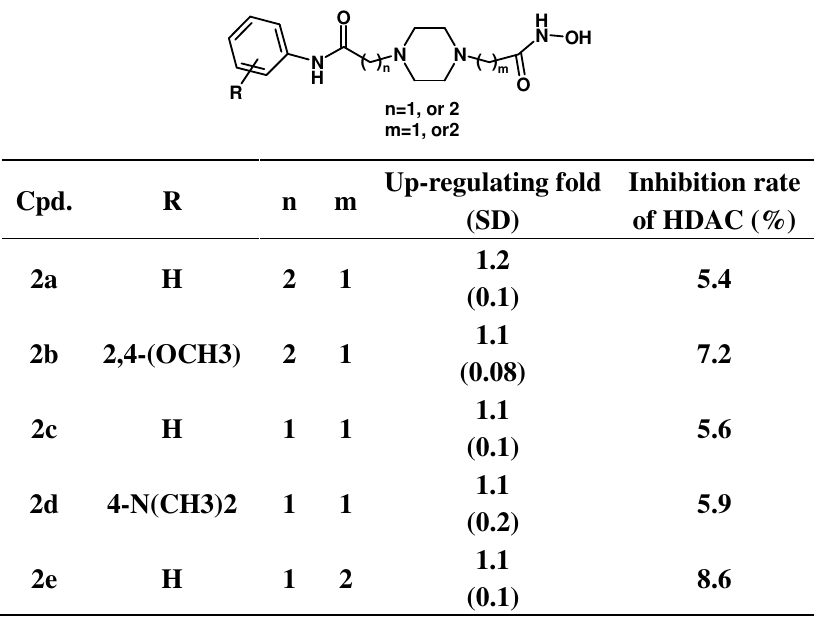
Table 2. Up-regulating activities of CLA-1 expression in HepG2 cells and inhibition rate of HDAC of compounds 2a-e .